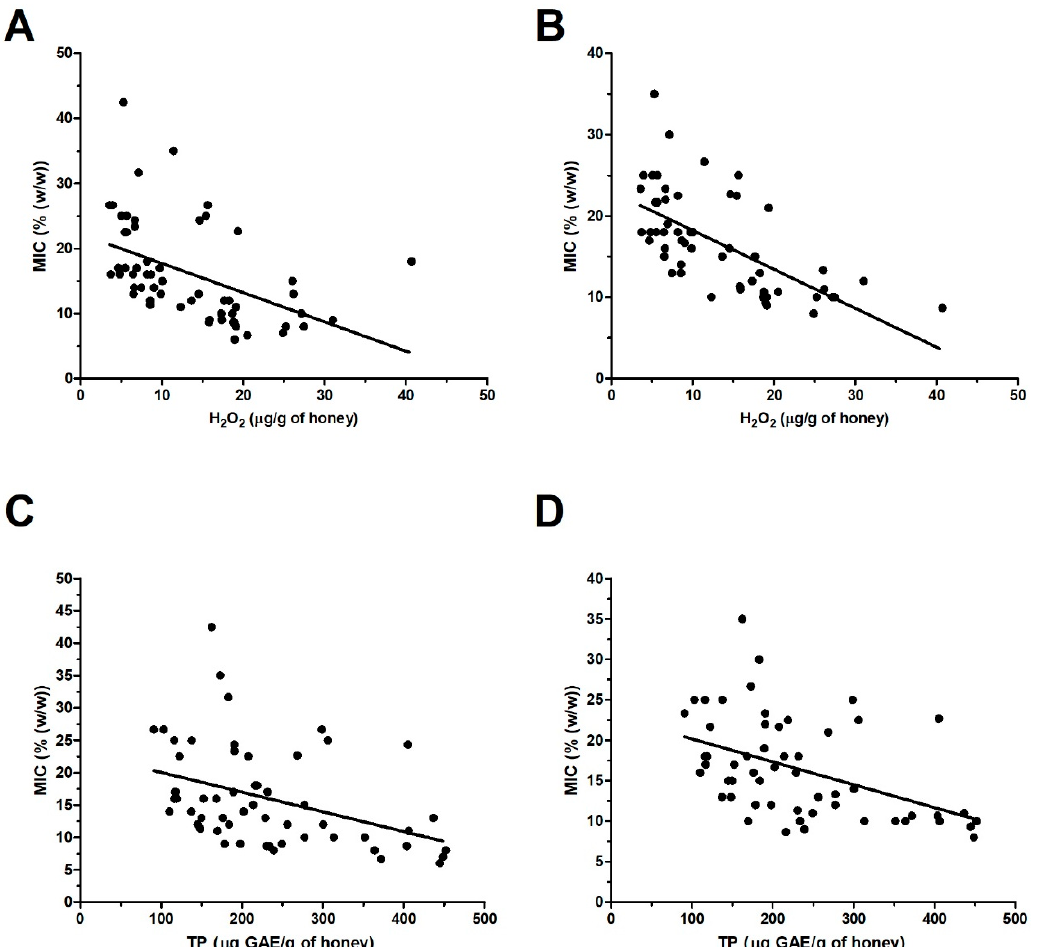
Figure 8. Graphical representation of the relationship between the content of H 2 O 2 ( A , B ) or total polyphenol (TP) content ( C , D ) and the overall antibacterial activity of blossom honey samples ( n = 57) against Staphylococcus aureus ( A , C ) and Pseudomonas aeruginosa ( B , D ) isolates. A Pearson correlation test was used for correlation analysis.